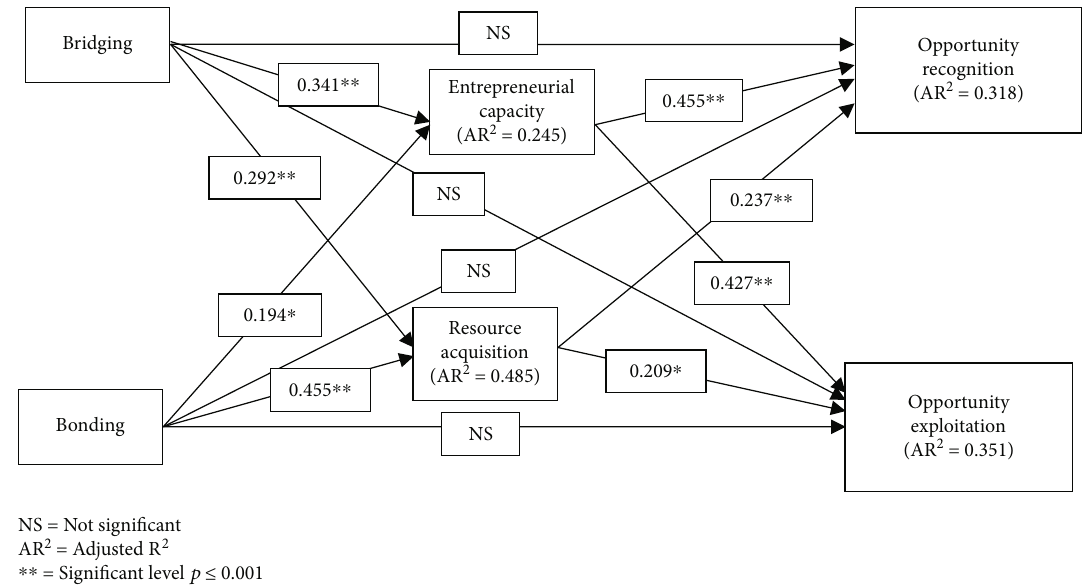
Figure 3: Tested research model (note: developed by the